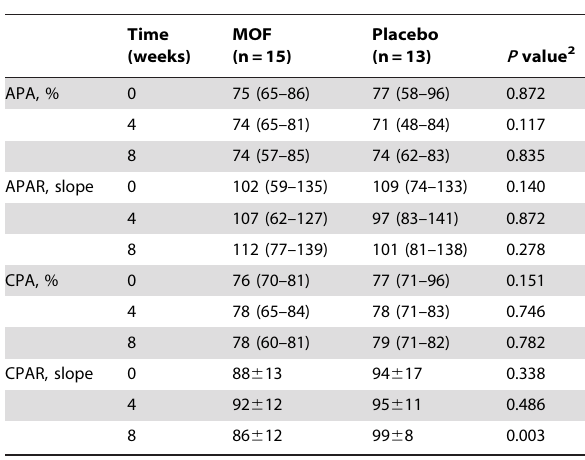
Table 3. Platelet aggregation parameters. 1